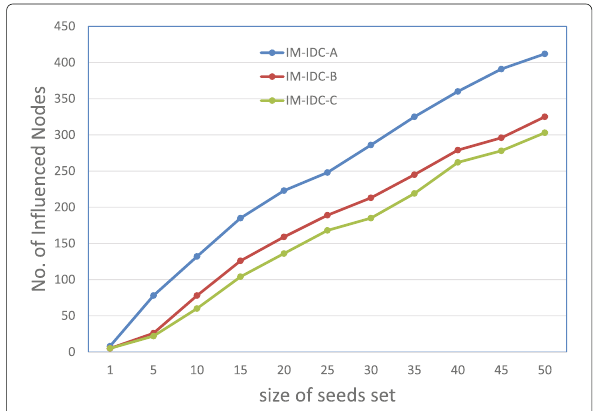
Fig. 5 The No. of influence set size on DBLP data while increasing the size of seed nodes, where IM-IDC-A, IM-IDC-B, and IM-IDC-C are A PPRO IM-IDC with low , medium , and high Poisson distribution parameters